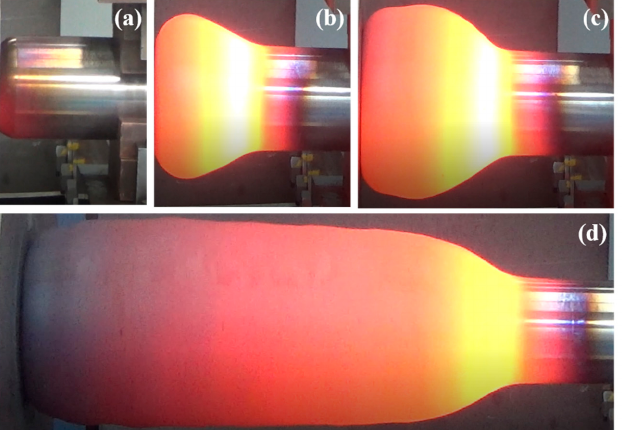
Figure 23. Trial process of large-scale electric upsetting at different stages: ( a ) the preheating stage; ( b ) the primary stage of forming process; ( c ) the intermediate stage of forming process; ( d ) the completed state.